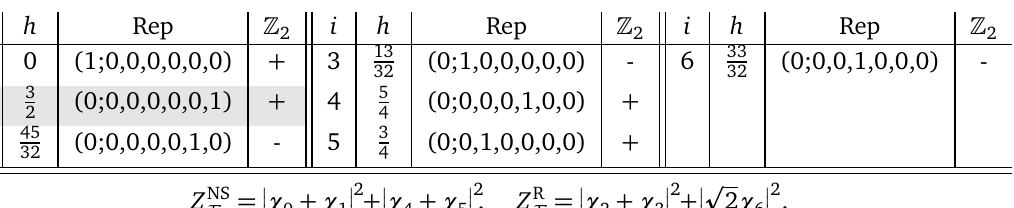
Table 14: Sp ( 12 ) : primaries labeled by i are characterized by weights h and Sp ( 12 ) Dynkin 1 ( τ ) . We highlight the primary related to the center labels. Their characters are denoted by χ i symmetry (cid:90) . The partition functions for F in the NS and R sectors are also 2